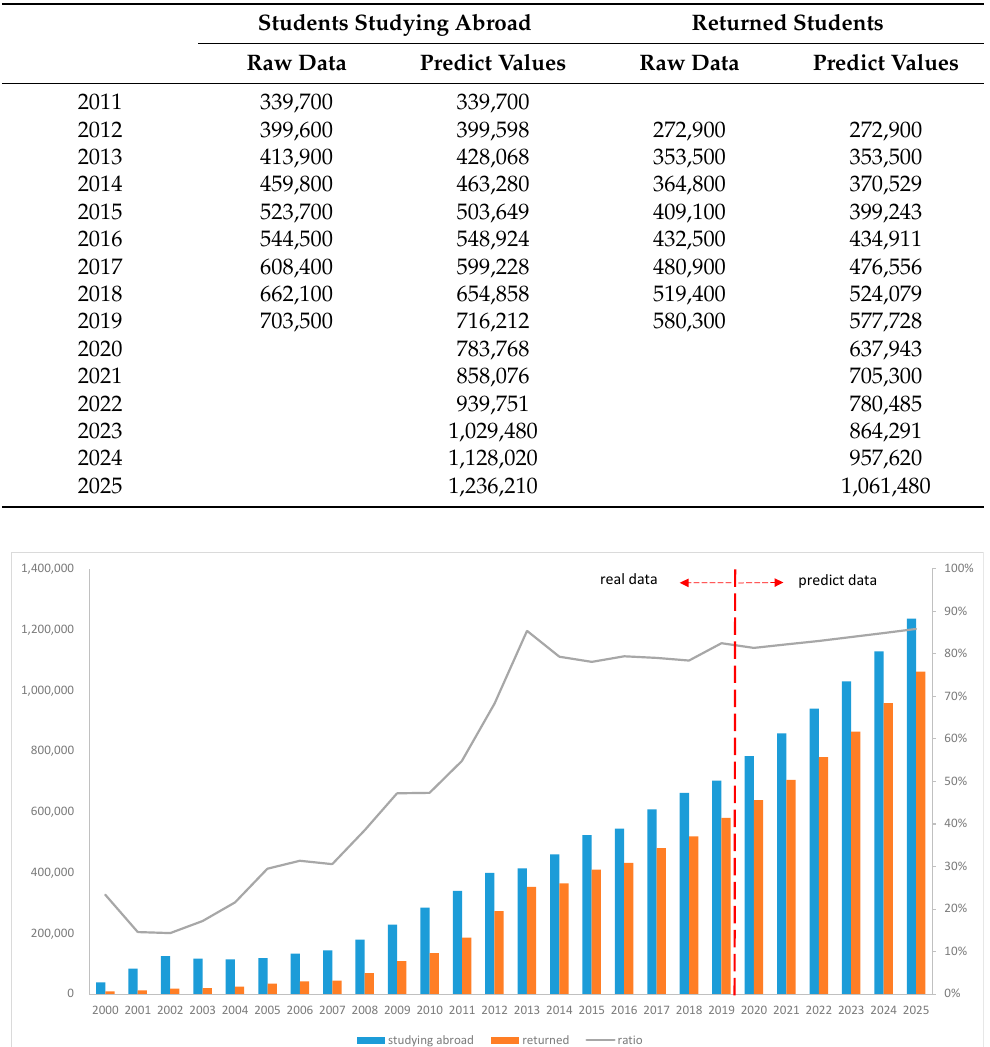
Table 4. Results of the prediction for students studying abroad and returned students, from 2020 to 2025.